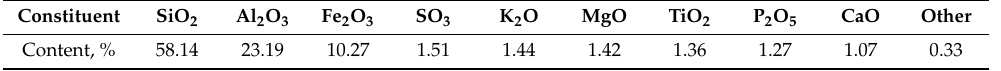
Table 2. Ash XRF (X–ray fluorescence) analysis of Fushun oil